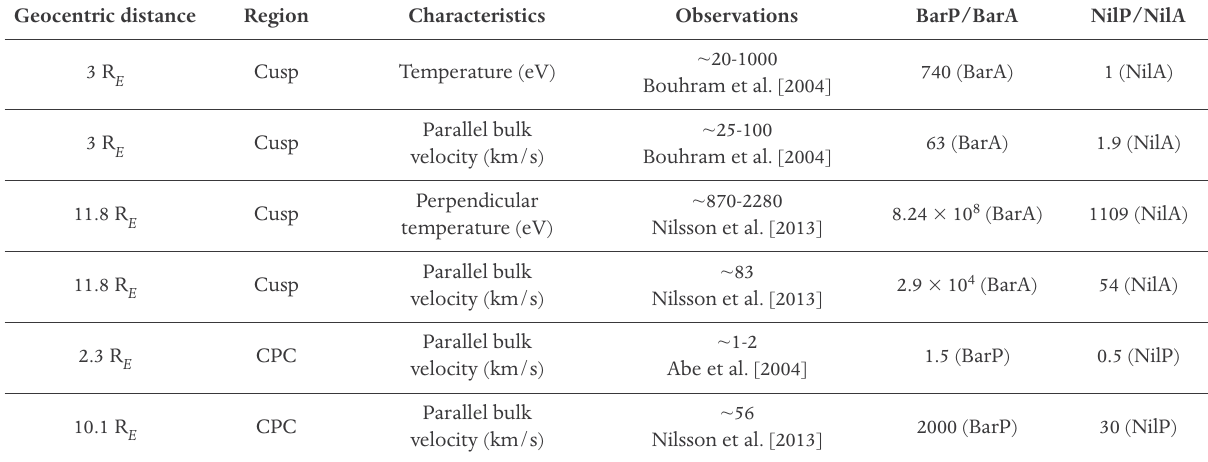
Table 1. Comparison between observational and simulation results for O +